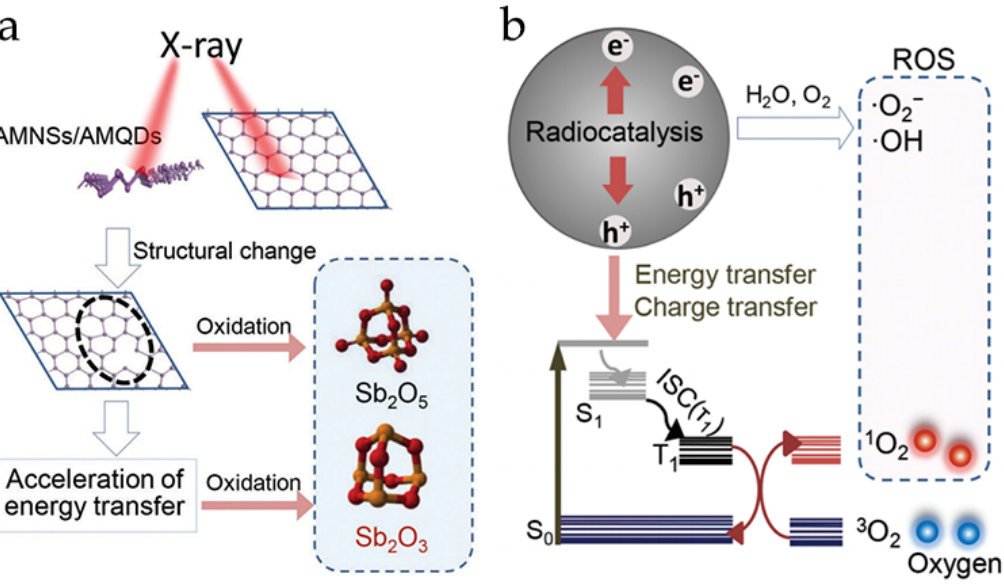
Figure 14. Mechanism of antimonene in the treatment of cancer. Reprinted with permission from Ref. [67]. Copyright 2019, John Wiley and Sons.